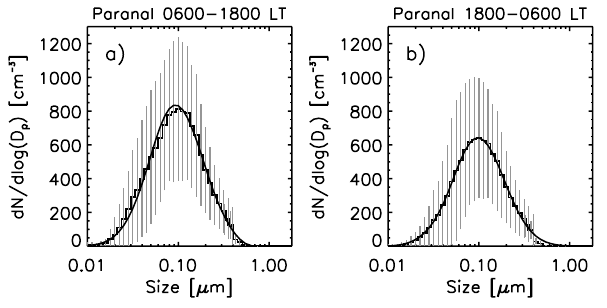
Fig. 13. Mean aerosol number size distributions (normalized for bin width to base-10 logarithm) between 0.01 and 0.3µm diameter with one-standard-deviationbars as measured at Paposo (690ma.m.s.l.). Upper panels show data recorded between 15 and 30 October 2008 (Period 1) and lower panels are for the period 1 to 15 November 2008 (Period 2), between 3–5a.m. local time (left panels) and 3–5p.m. local time (right panels). The day-of-year range is given in the title for each panel. 66